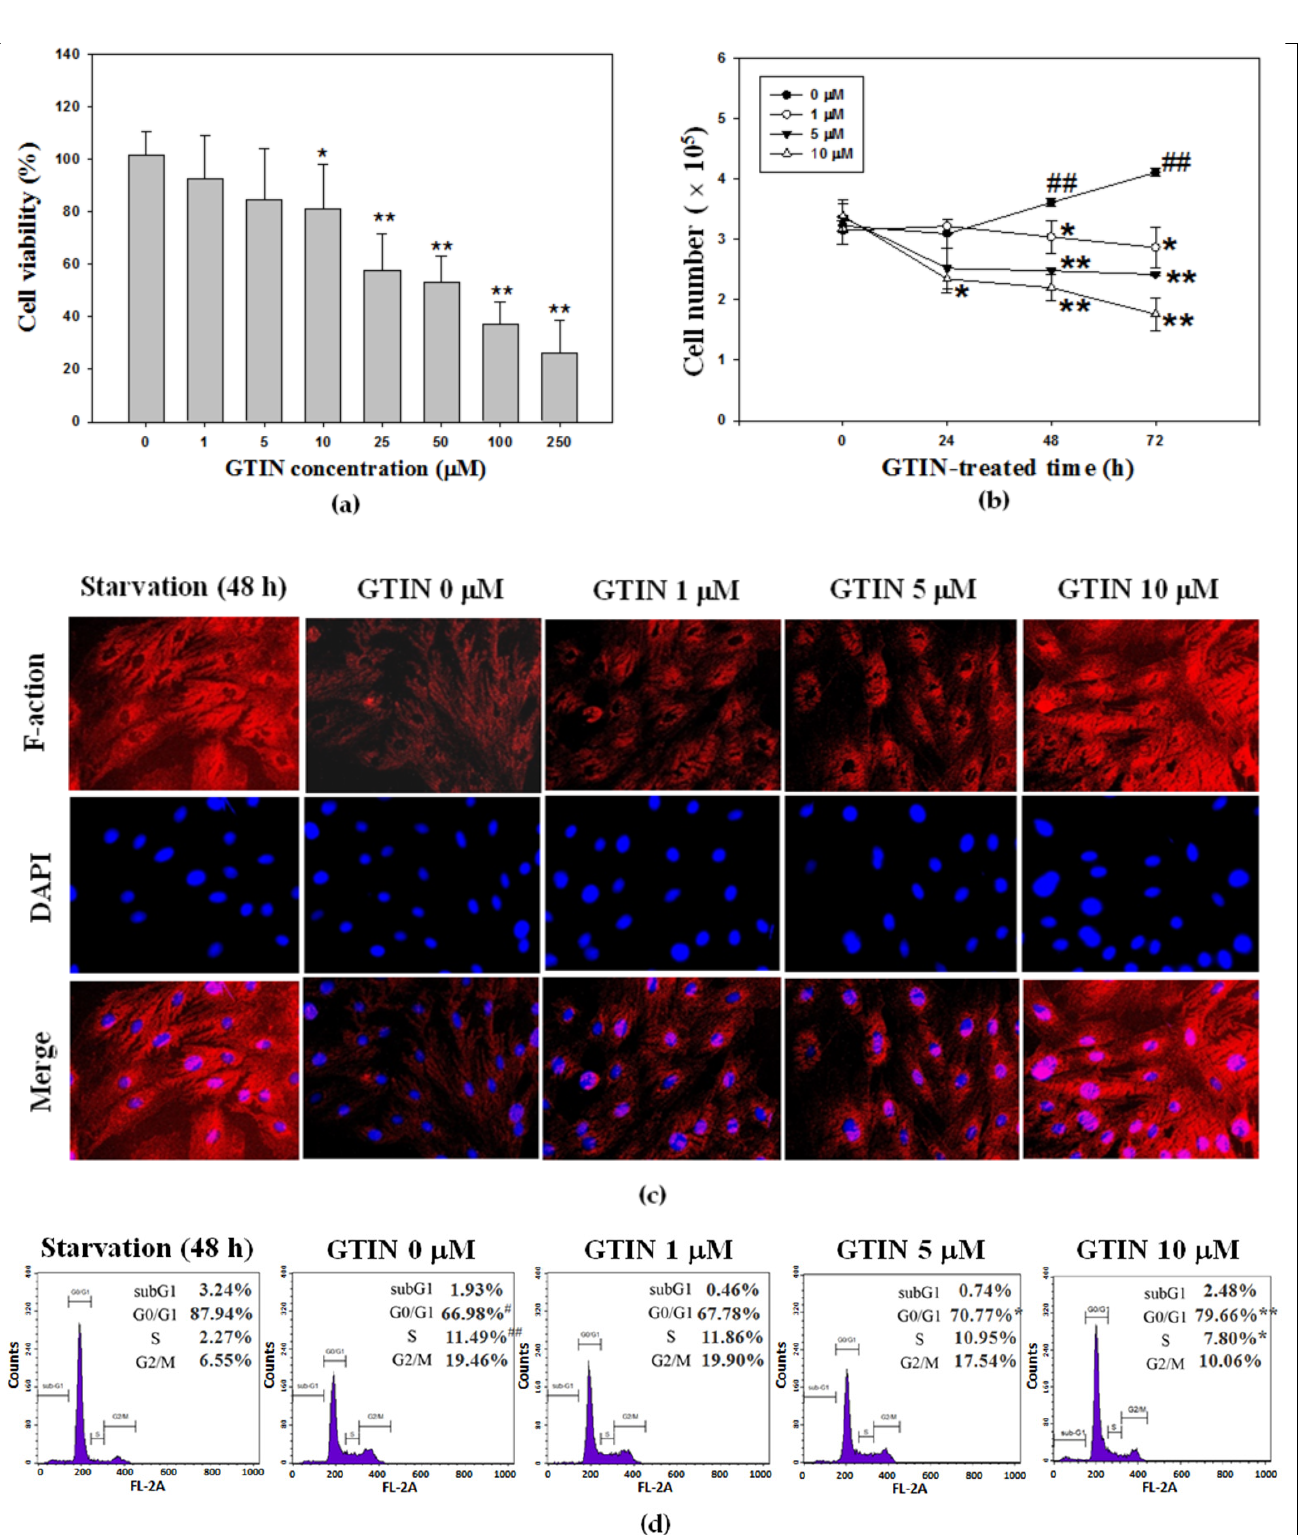
Figure 1. GTIN affected cell viability, proliferation, phenotype switch and cell-cycle progression in VSMCs ( a ) A7r5 cells were treated with GTIN at various doses (0–250 µ M) for 24 h. Cell viability was determined by MTT method. The result was showed as mean ± SD of three repeats from at least three independent experiments. * p < 0.05, ** p < 0.01 compared with the untreated control via one-way ANOVA with Dunnett’s post-hoc analysis. ( b ) A7r5 cells were treated with GTIN at the indicated doses (1, 5 and 10 μ M) for 24, 48 and 72 h. The cell growth curve was analyzed by applying trypan blue exclusion assay. The quantitative result was showed as mean ± SD of three repeats from at least three independent experiments. # p < 0.05, ## p < 0.01 compared with the 0-h untreated control via one-way ANOVA with Dunnett’s post-hoc analysis. * p < 0.05, ** p < 0.01 compared with the respective time point of the untreated control via one-